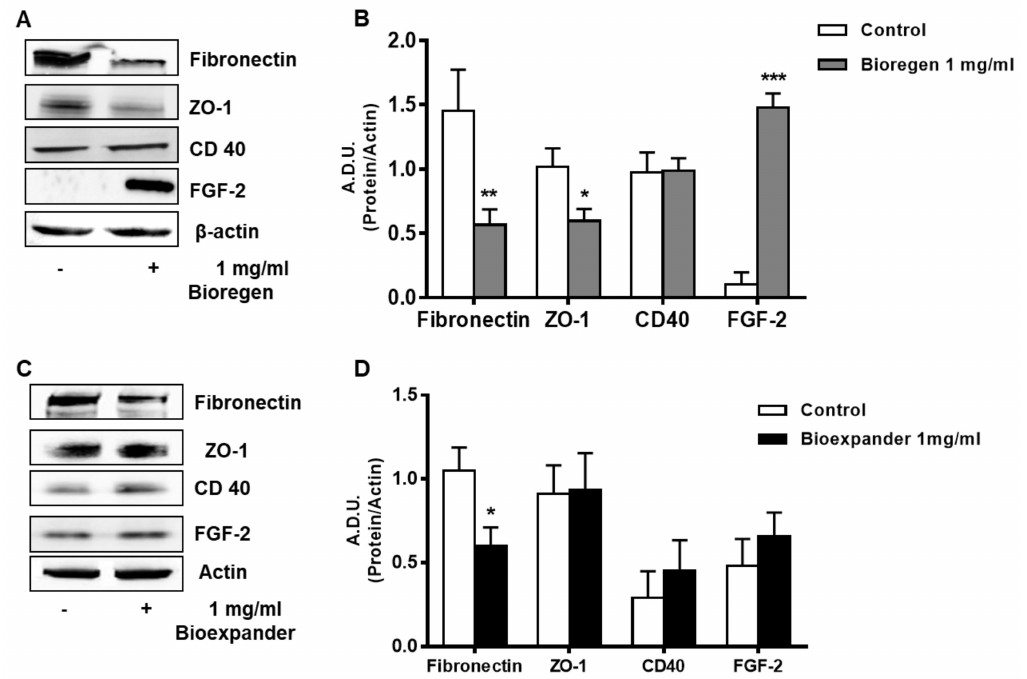
Figure 4. Analysis of the proteins involved in angiogenesis and inflammation in ECs. HUVEC cells were treated for 18 h with the 1 mg / mL HA preparations Bioregen ® ( A , B ) (grey columns) and Bioexpander ® ( C , D ) (black columns). In panels ( A , C ), a representative blot out of 3 is shown, while panels ( B , D ) report protein quantification. Data are reported as A.D.U of the protein of interest with respect to